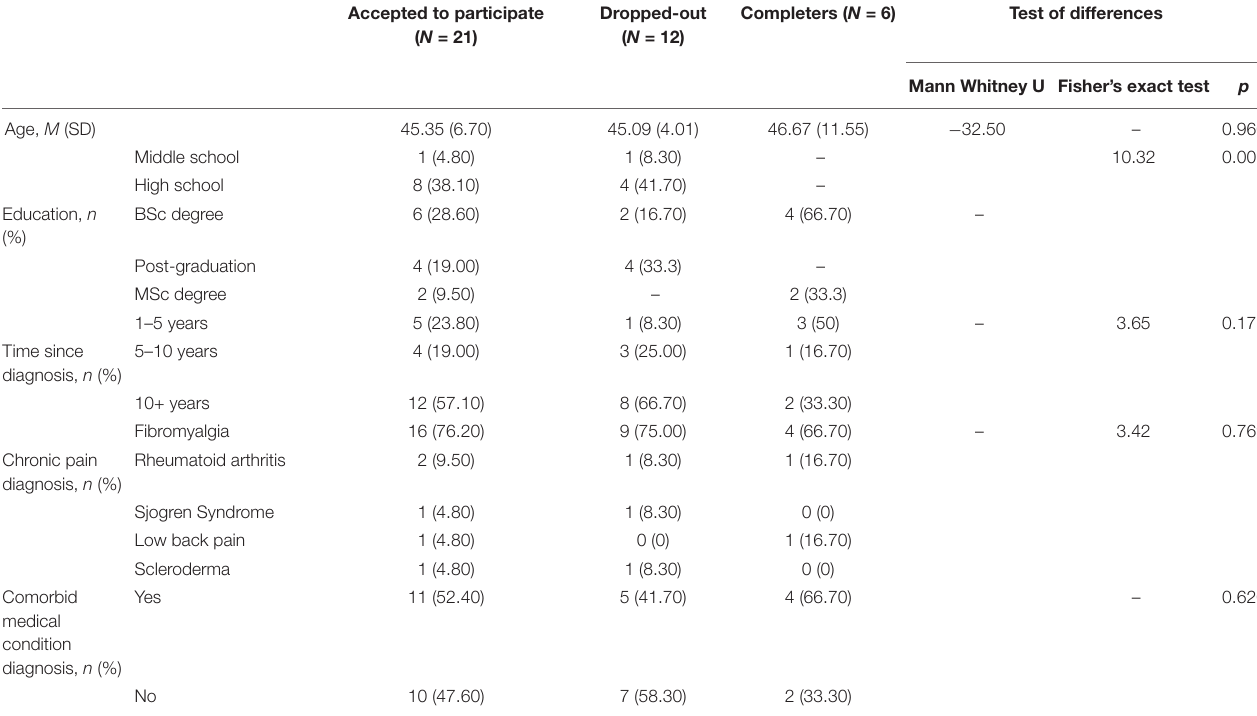
TABLE 3 | Descriptives and frequencies of the demographic and clinical variables in study across groups, and tests of differences between participants who dropped out and